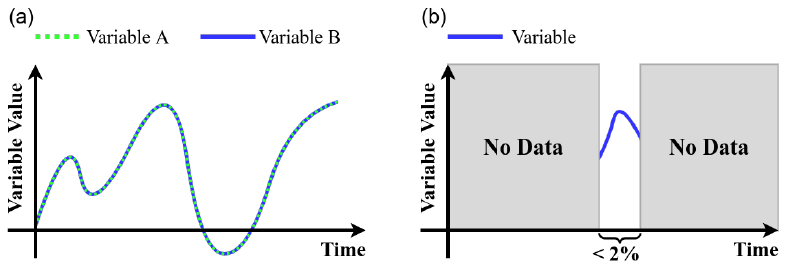
Figure 10. Data cleansing process rules: ( a ) remove duplicates and ( b ) empty and null values .